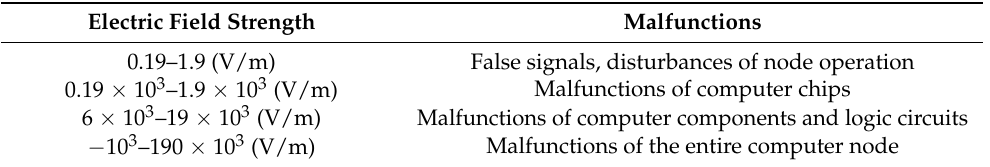
Table 1. Thresholds of the electric field strength for various malfunctions of the electronic compounds in a computer